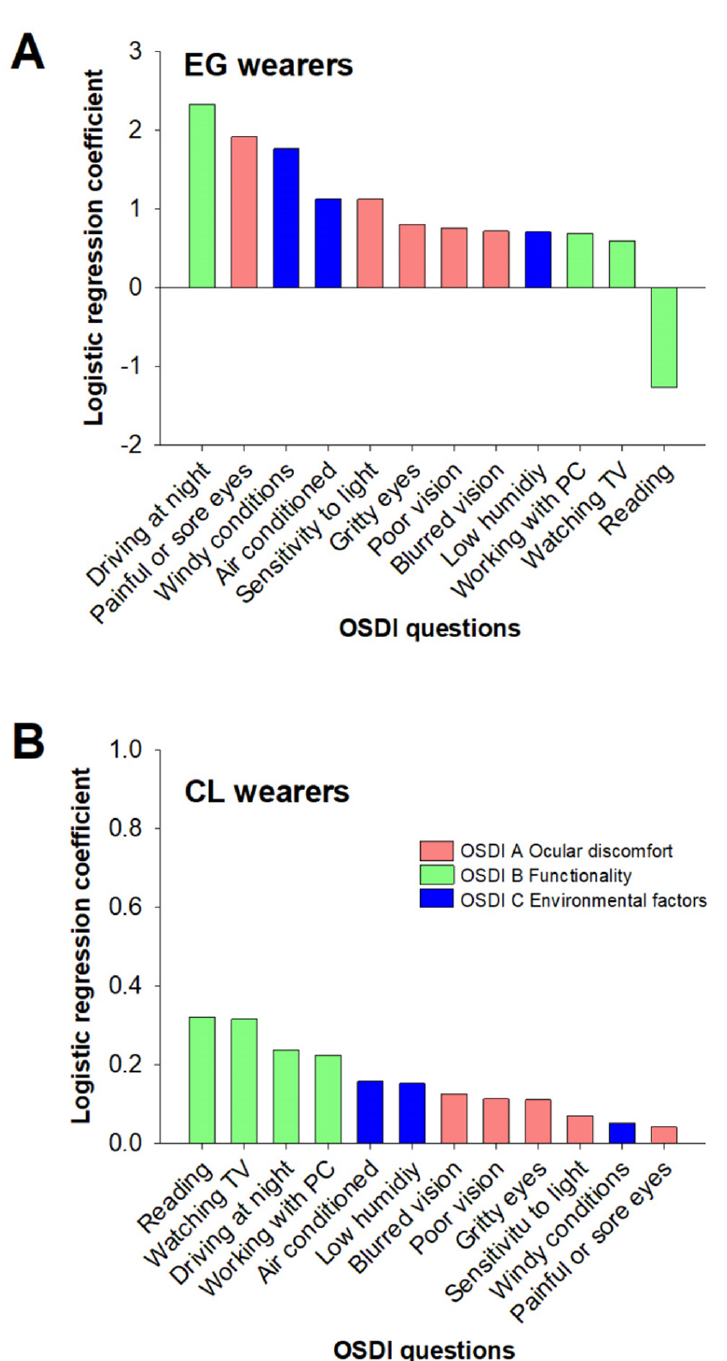
Figure 1. Logistic regression coefficients calculated for the twelve OSDI questions in young eyeglasses (EG) ( A ) and contact lens (CL) ( B ) wearers. In the EG group, the values given to all the questions contributed significantly ( p < 0.001, t - test of conformity). In the CL group, only the score given to “reading” was nearly significant ( p = 0.05, t -test of conformity).